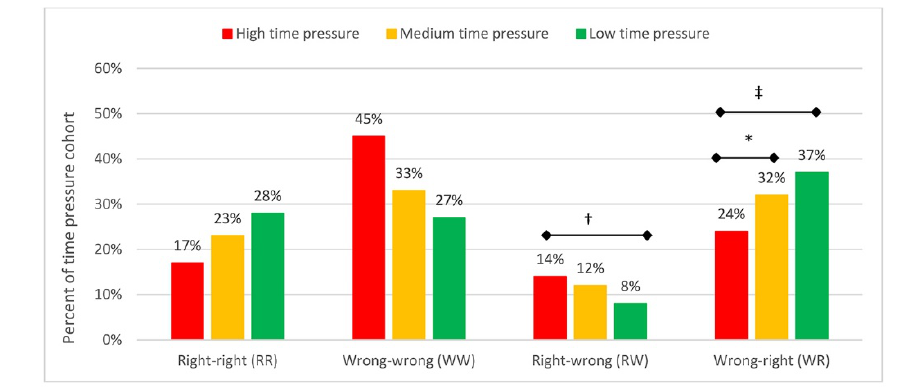
Figure 3 Answer direction between stages 1 and 2 according to time pressure condition